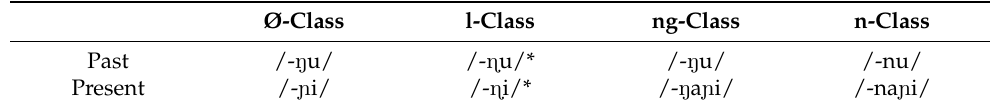
Table 6. Pitjantjatjara past and present tense endings.